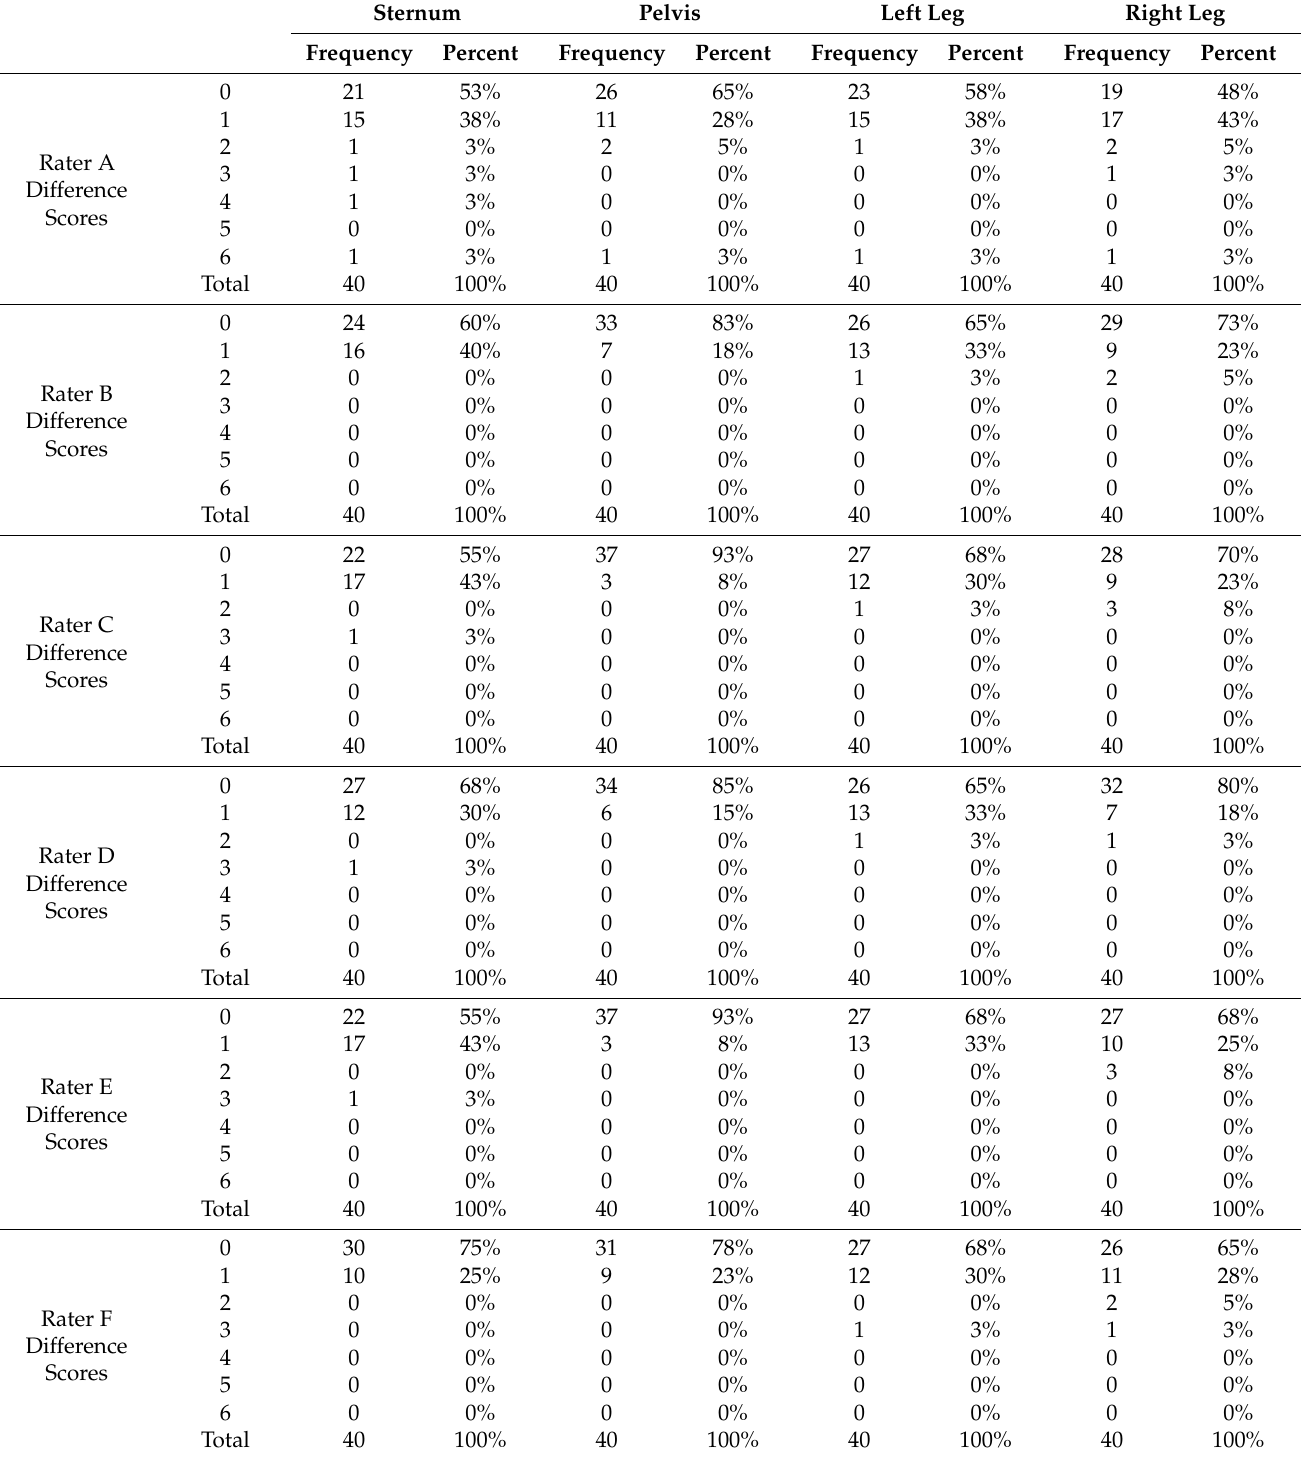
(Table 1). There was slightly higher agreement for chest, pelvis and left leg ratings (mean difference score of ≤ 1 segment across all raters of 97%, 99%, 98%, respectively) compared with right leg ratings (93%). Table 1. Frequency and percent of Intra-Rater Reliability of Human Raters (by Difference Score for each body